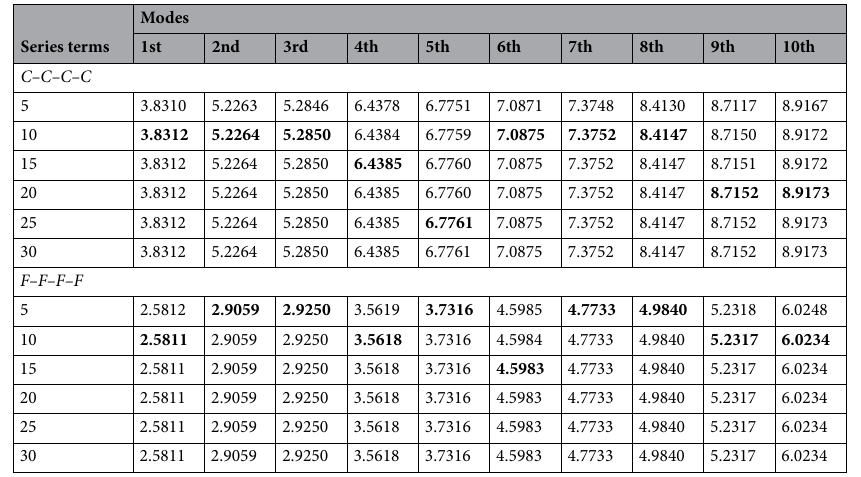
Table 1. Convergence study of the first ten frequency parameters ( (cid:31) ort ) of orthotropic square plates with E y E x = 2.5 and ν x ν y = ( 0.3 ) 2 . Convergent results are in (cid:31)